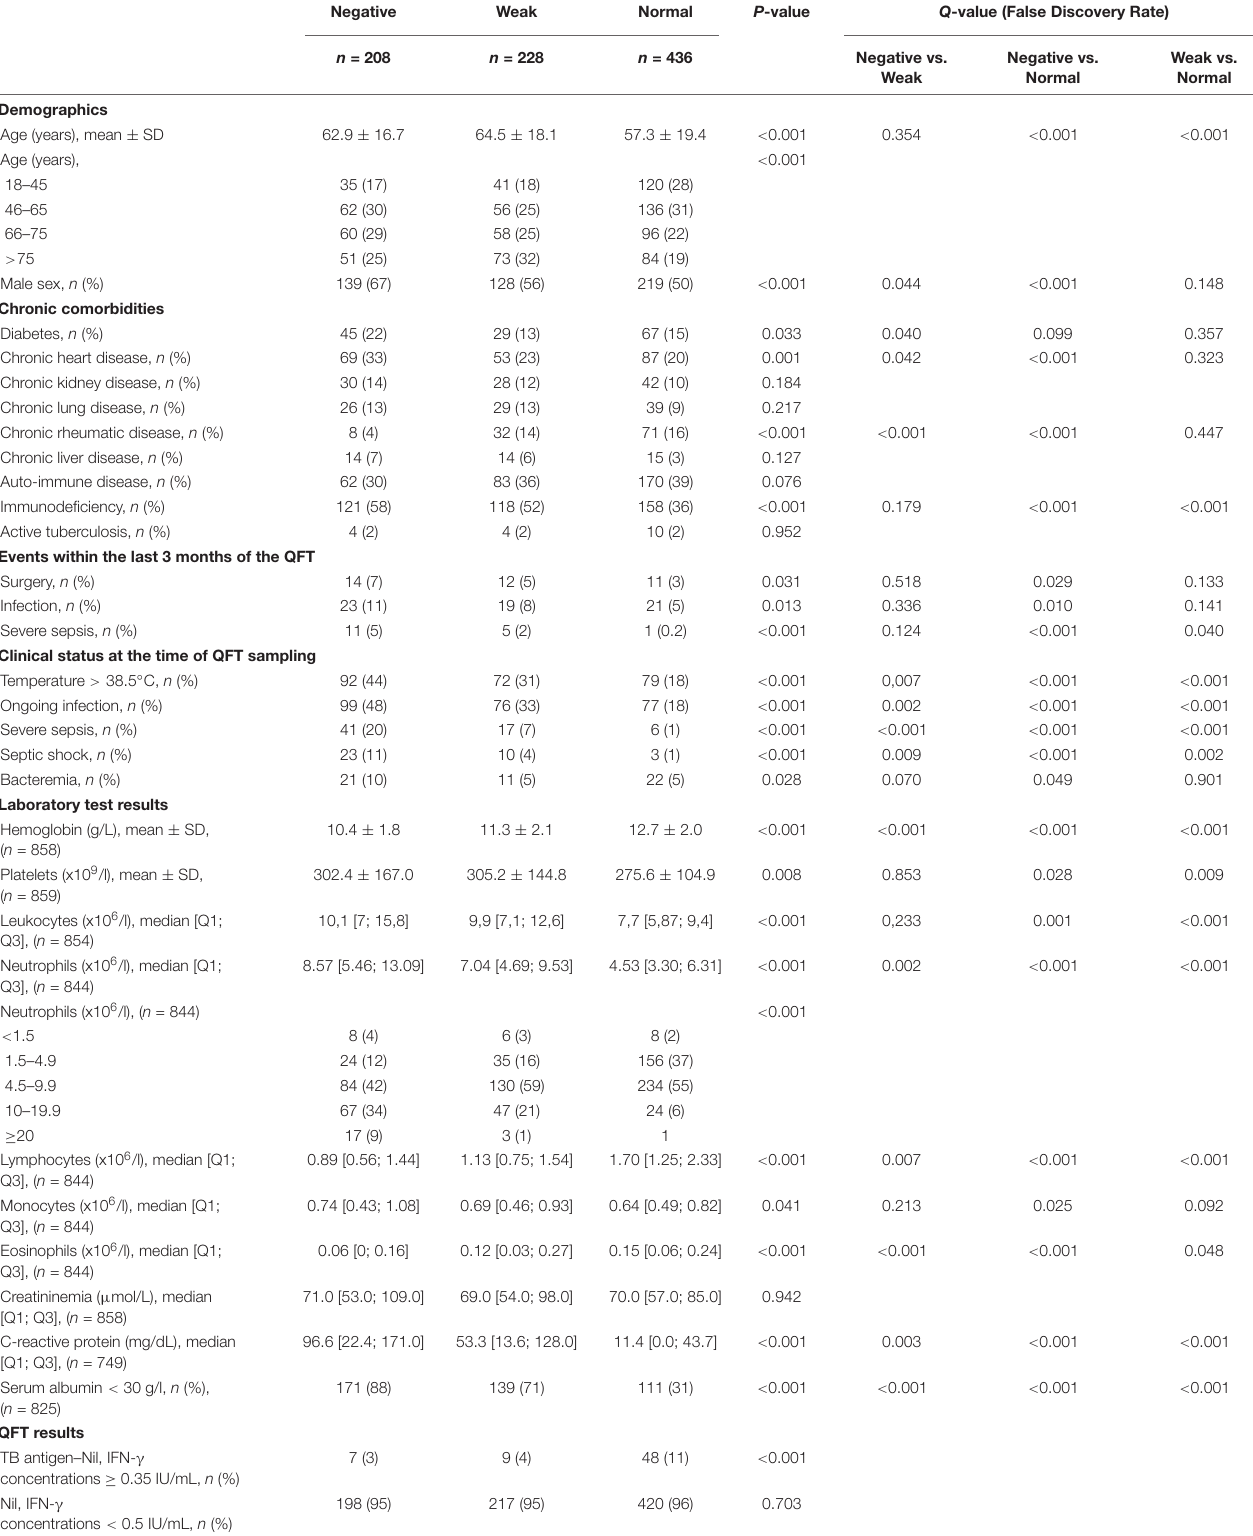
TABLE 1 | Baseline characteristics of patients according to the mitogen response on QFT testing.